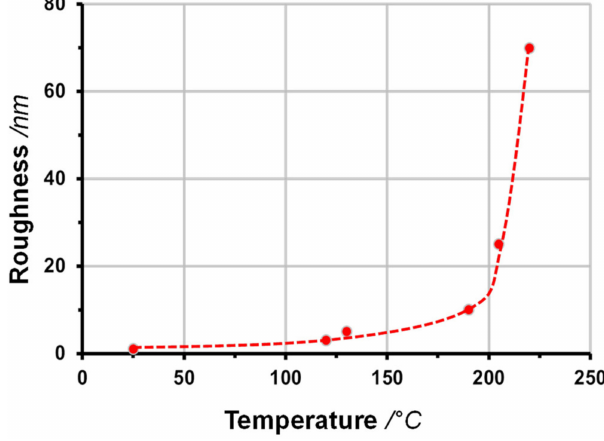
Figure 5. Roughness of carbon films, deposited by MSIBD with 120 eV carbon ions, in dependence on the deposition temperature. Film thickness about 100 nm. Data from [48].